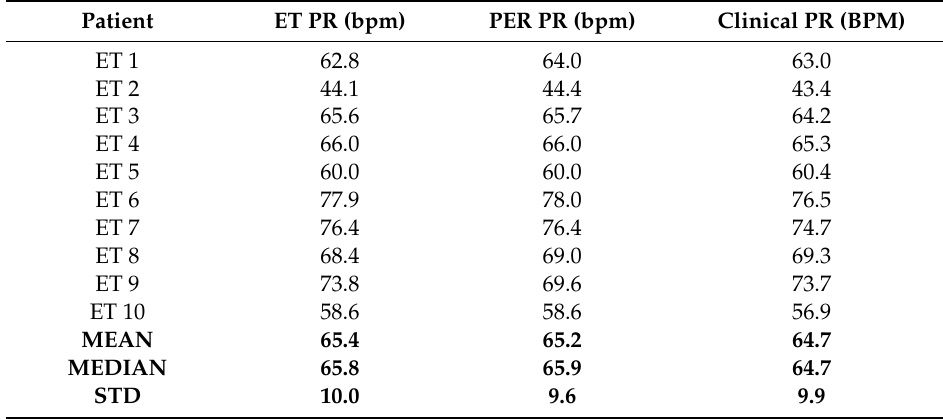
Table 2. The mean pulse rate reading from each patient for the ET, PER and Clinical sensors. Standard mean, median and standard deviation of the results is